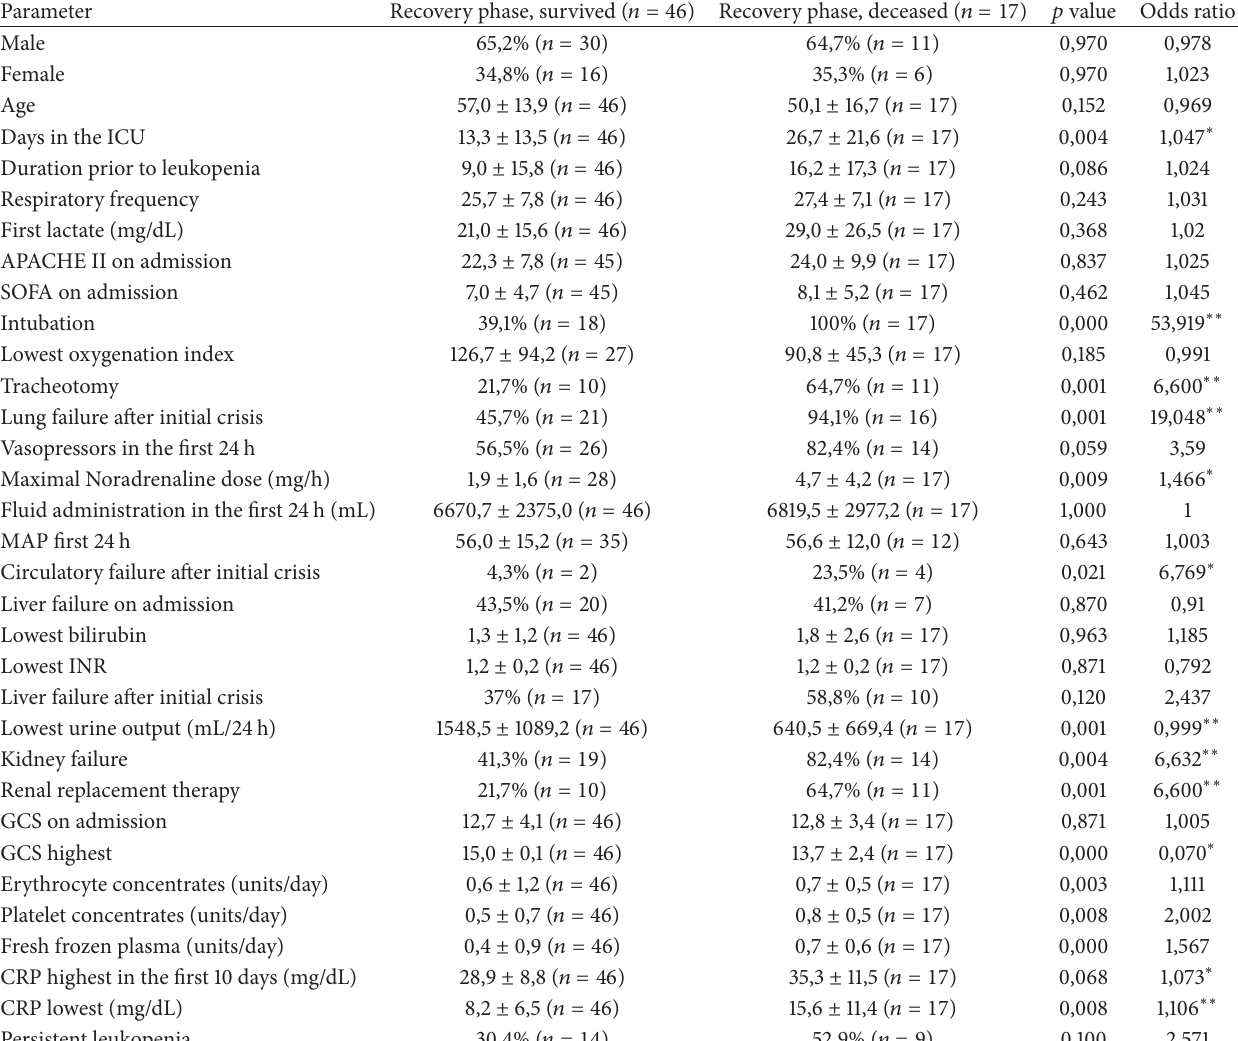
Table 2: Comparison of patients in the recovery phase after overcoming the initial sepsis. Values are displayed as mean ± standard deviation; ∗ / ∗∗ indicate level of